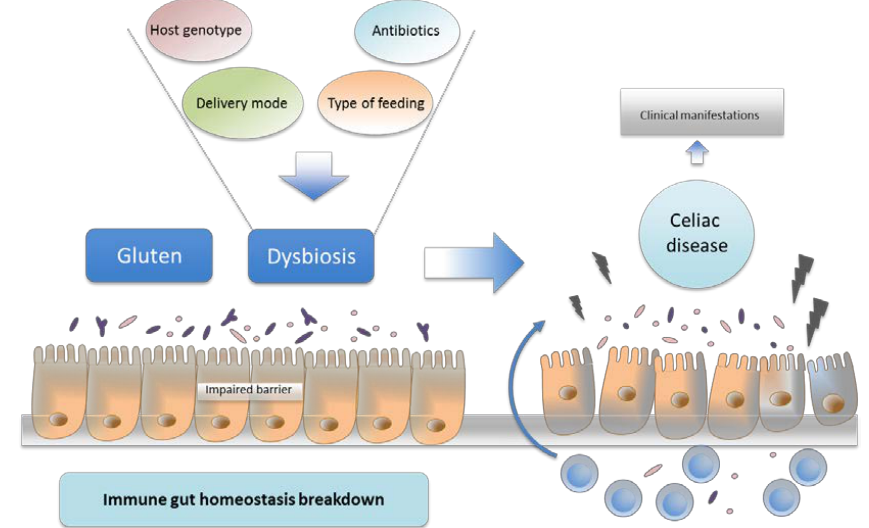
Figure 1. Proposed model for celiac disease (CD) pathogenesis. Specific host genetic makeup and environmental factors could promote the colonization of pathobionts and reduce symbionts, thus leading to dysbiosis. Dysbiosis may contribute to disrupting the immune homeostasis and gut integrity, thereby favoring CD onset and aggravating the